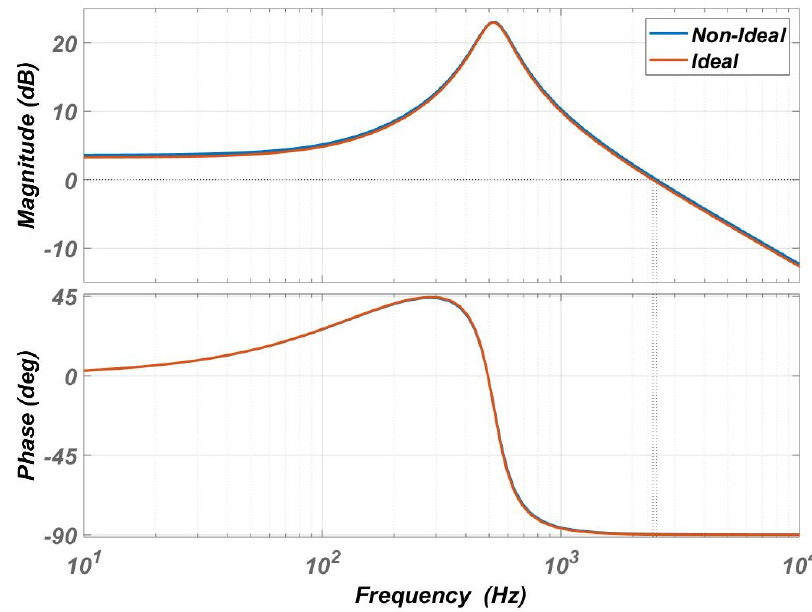
Figure 7. G id for ideal and non-ideal buck converters for when R c = R L = 0.